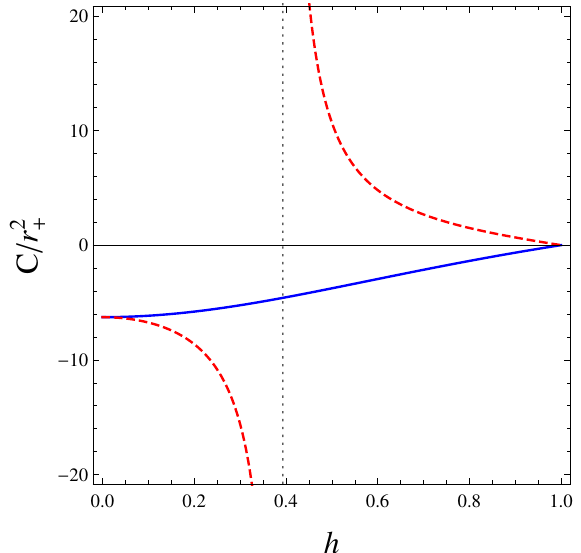
Figure 1. Plots of heat capacities C Ω (blue solid) and C J (red dashed) as functions of h . C J diverges at √ (cid:113) 2 h c = 3 − 1. C J is negative for h < h c and positive for h > h c . The heat capacities coincide at the 3 limit values h = 0 (Schwarzschild holes) and h = 1 (extreme Kerr